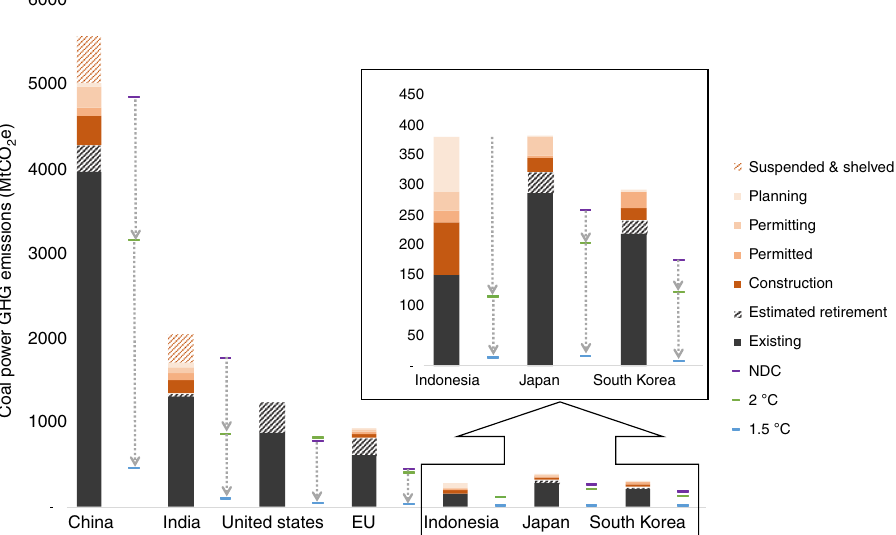
Fig. 2 Emissions gaps from coal infrastructure. Emissions from existing and proposed coal plants create gaps for achieving the NDC (purple), well-below 2 °C (green), and 1.5 °C (blue) targets globally ( a , shown over time) and for key countries and regions ( b , shown for 2030). Emissions pathways to comply with climate goals are based on country pledges for the NDC scenario and cost-effective global reductions for the well-below 2 °C and 1.5 °C scenarios. Estimated retirements in China, the US, and the EU are based on either unit-level announcements or national targets and policies; estimates in India, Indonesia, Japan, and South Korea are based on a 50-year unit lifetime. (Source data are provided as a Source Data fi